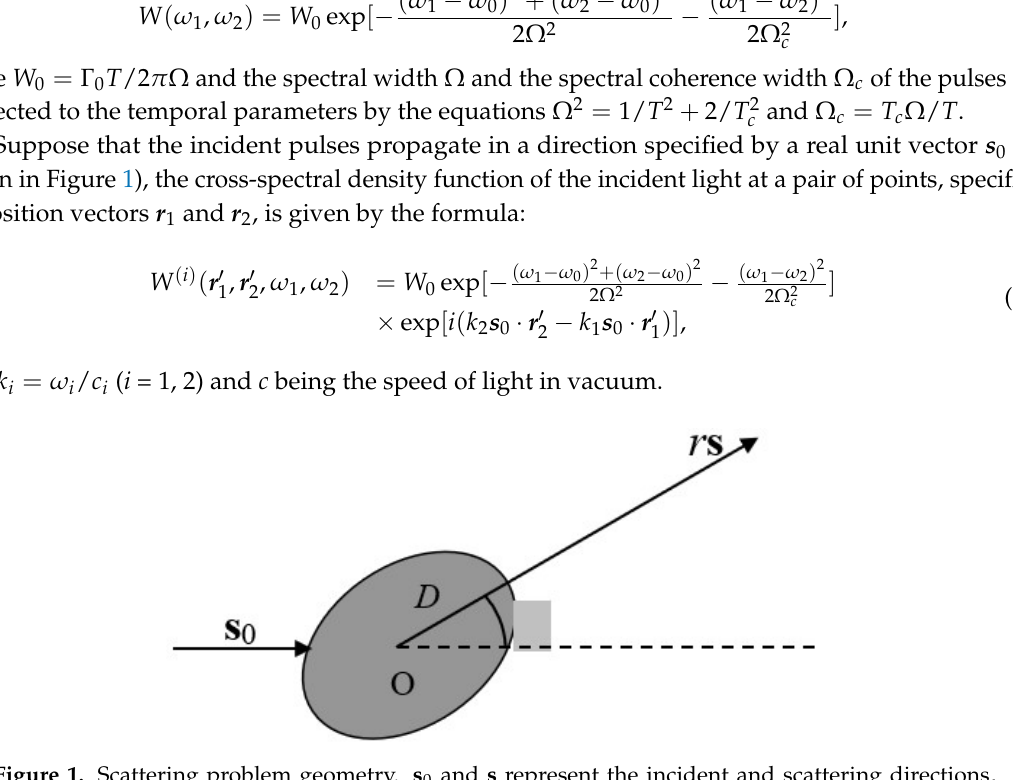
Figure 1. Scattering problem geometry. s 0 and s represent the incident and scattering directions, respectively. θ is the scattering angle, and D is the domain the scatterer occupies.